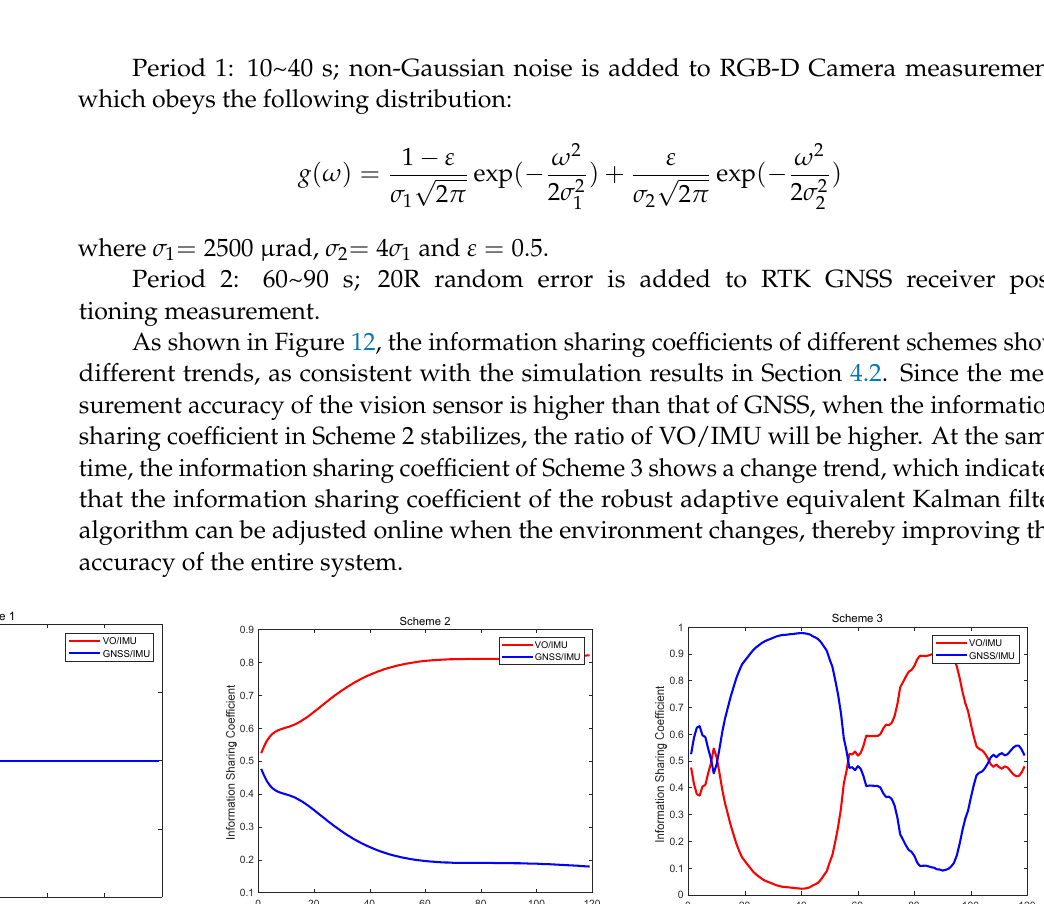
Figure 13. Position estimation for different scenarios.